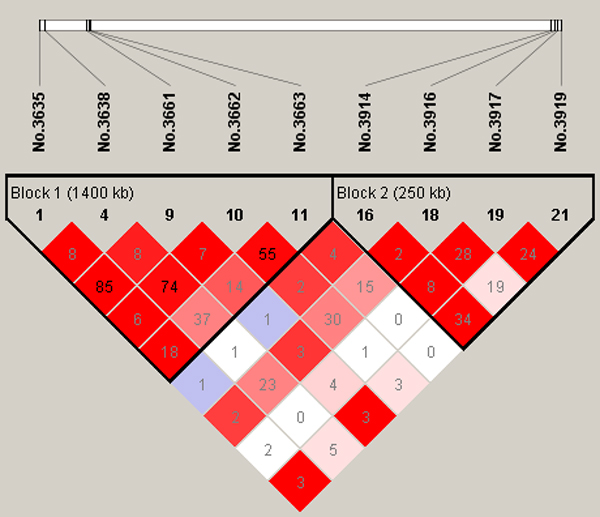
Linkage disequilibrium (LD) patterns for significant SNPs on chromosome 2. The true simulated QTN (No.3875 and No.4300, respectively) are also included in addition to the significant SNPs.